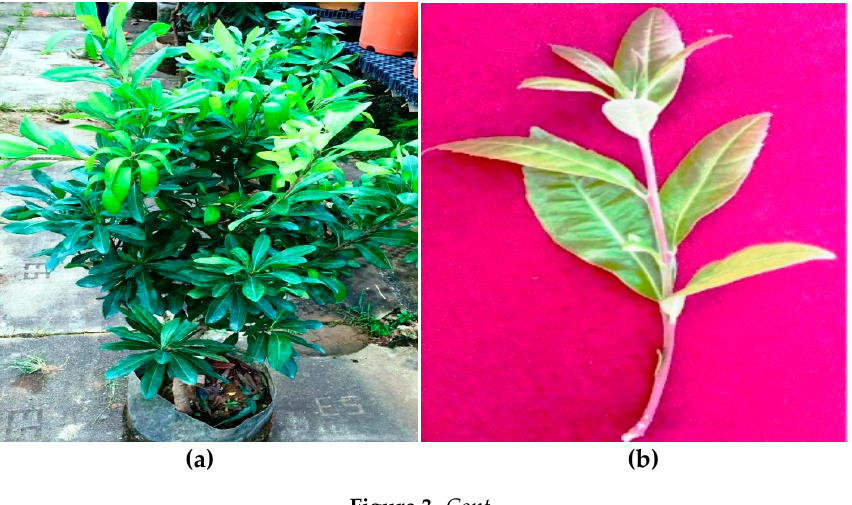
Figure 2. Natural distribution of Myrica esculenta . The shaded area represents the natural habitat of M. esculenta in the India.